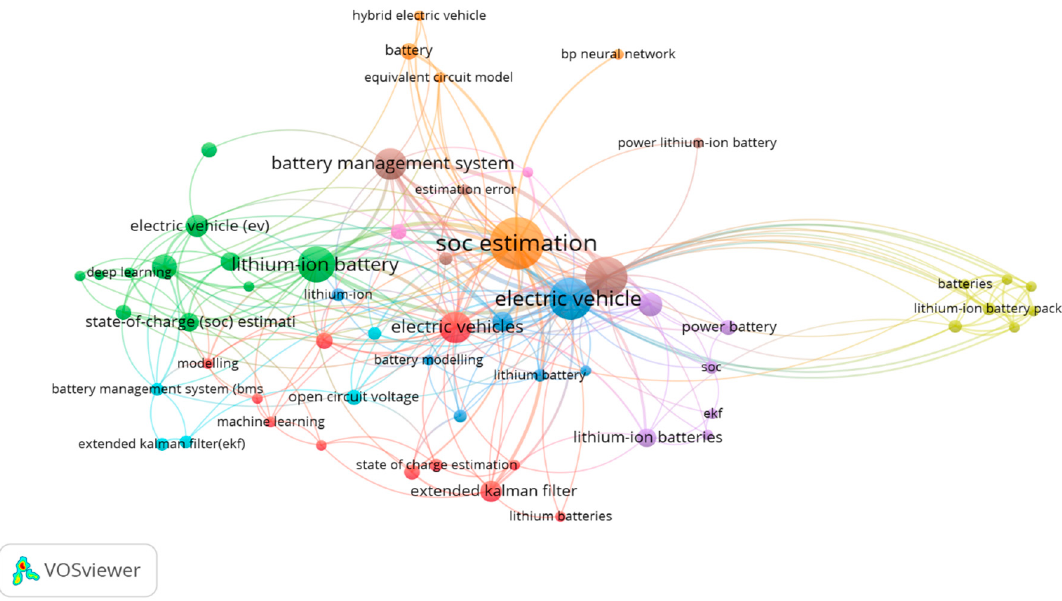
Figure 19. Mapping of authors’ keyword and occurrence in the SCOPUS DB.